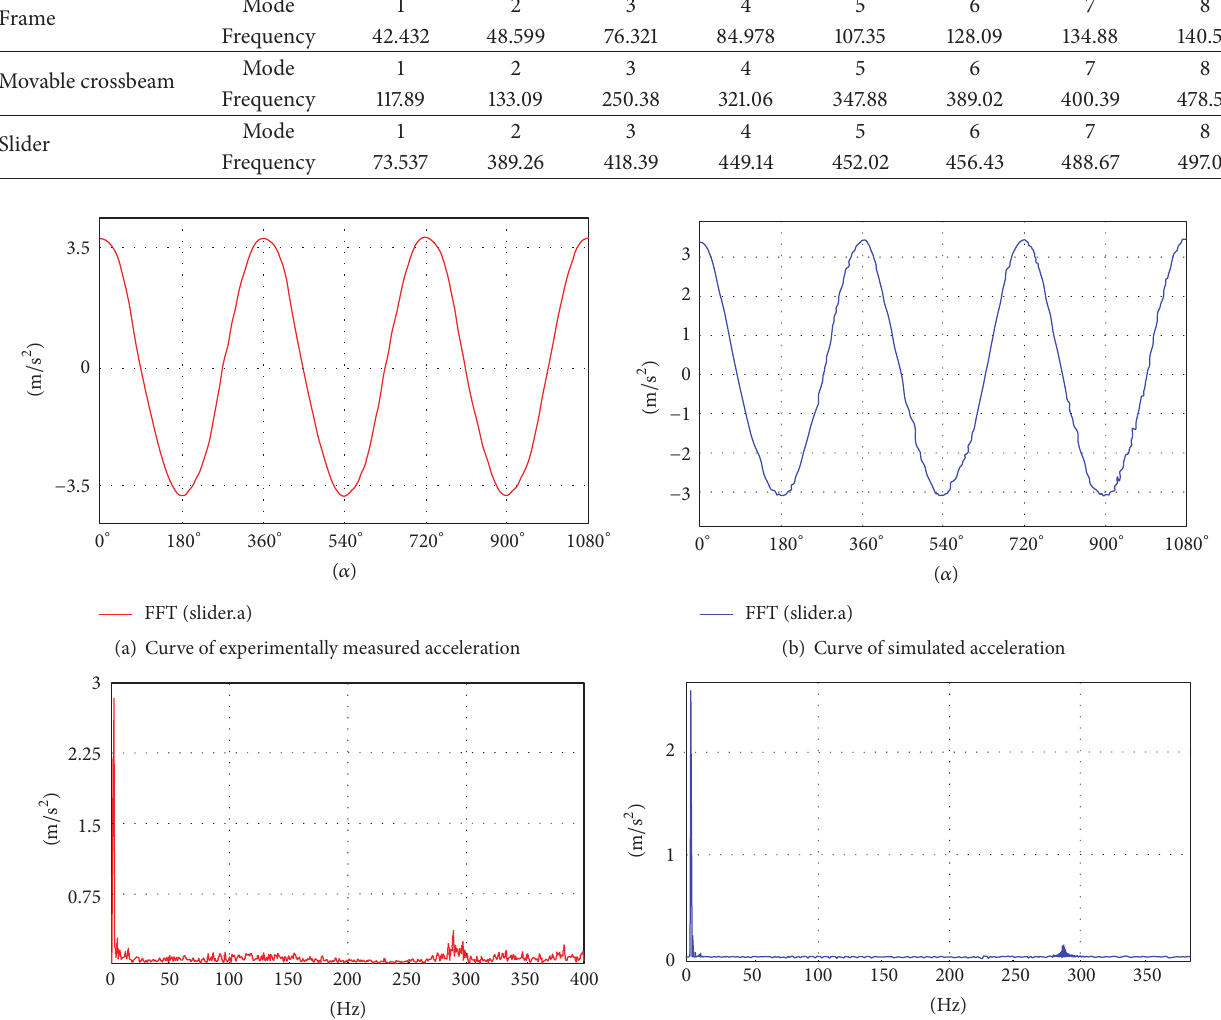
Table 5: Natural frequencies of main components of the punching press (Hz).